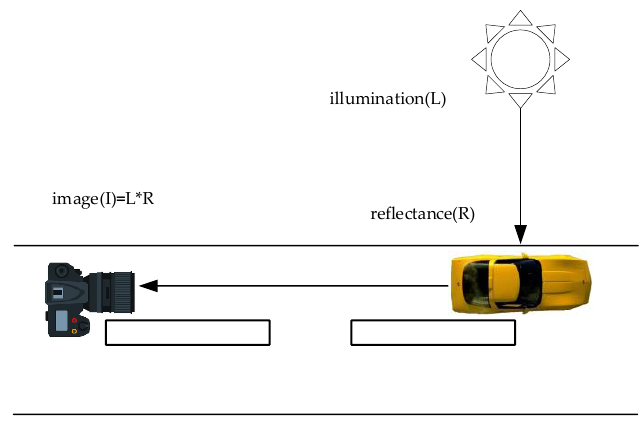
Figure 2. Sketch of Retinex theory.